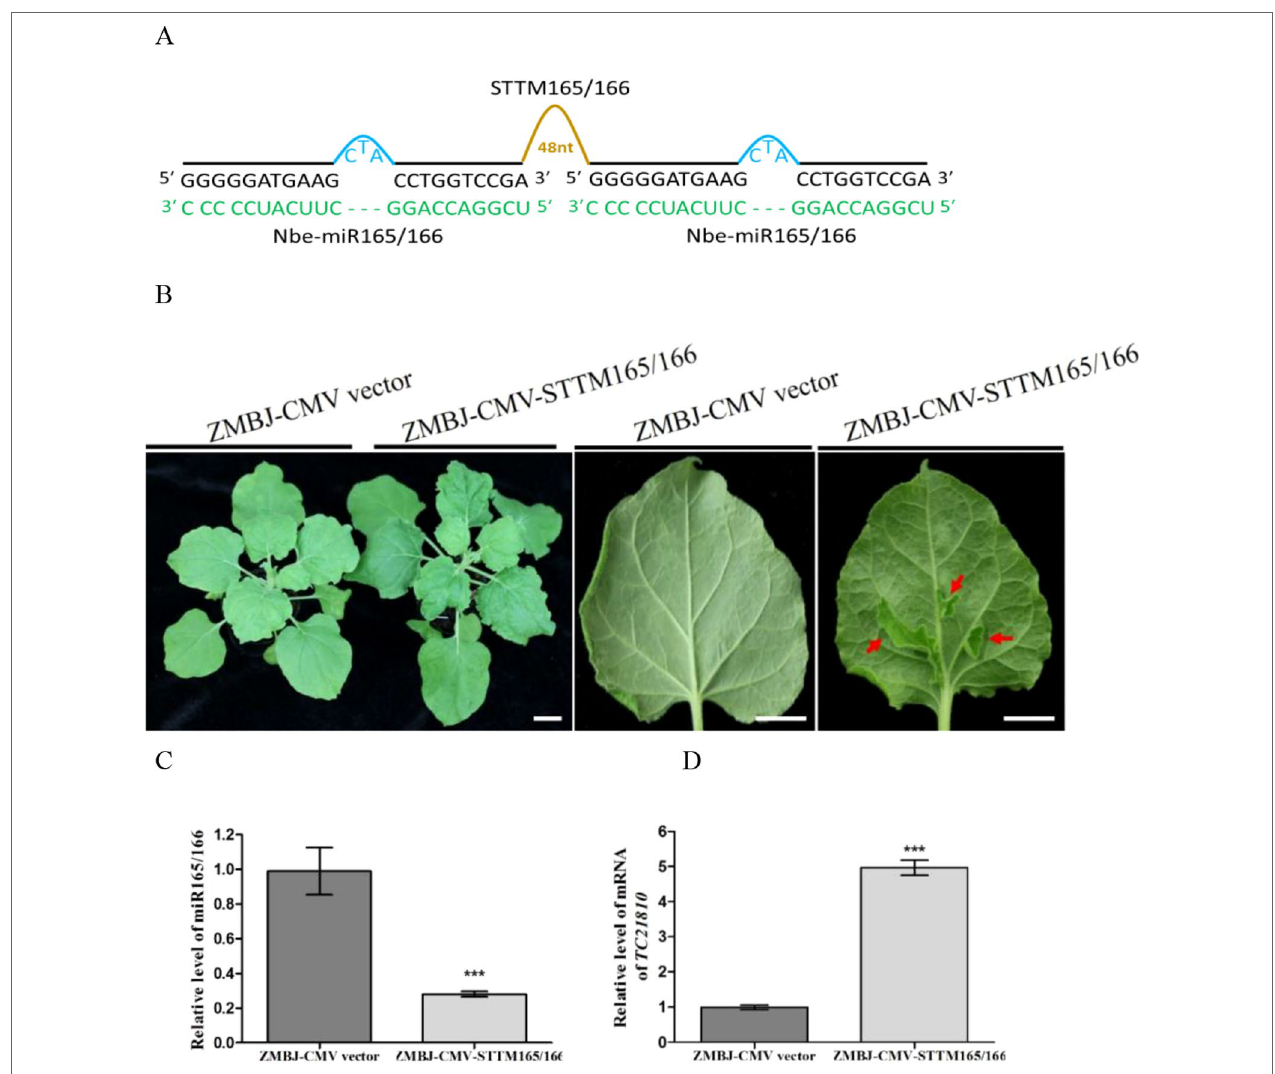
FIGURE 2 | Silencing miR165/166 expression in Nicotiana benthamiana using ZMBJ-CMV-STTM165/166. (A) A diagram of STTM165/166 insert in the ZMBJ-CMV- based VbMS vector. 48 nt, a 48 nt stem-loop linker; —, no nucleotide at this position. (B) Phenotypes of plants infected with ZMBJ-CMV (control) or ZMBJ-CMV- STTM165/166. Photographs were taken at 28 dpi. Images of two detached leaves (abaxial side) are shown on the right side. Red arrows indicate enations on the abaxial leaf side. Bars = 2 cm. (C) Relative expression of miR165/166 determined by stem-loop RT-qPCR. (D) Relative expression of miR165/166 target gene TC21810 in the ZMBJ-CMV (control) or ZMBJ-CMV-STTM165/166 infected maize plants. The 2 nd upmost young leaves were harvested from the assayed plants at 14 dpi and used for this study. The results were analyzed using the GraphPad Prism 5 software (GraphPad Software, Inc., La Jolla, CA, USA). Each bar represents the mean ± SEM from three independent experiments. Statistical significance between the two treatments was determined by the Student’s t -test. ***, p <